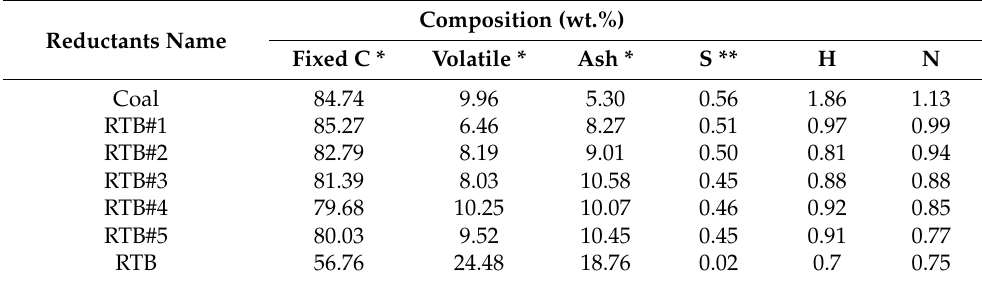
Table 3. Composition of the carbonaceous samples as a reductant.